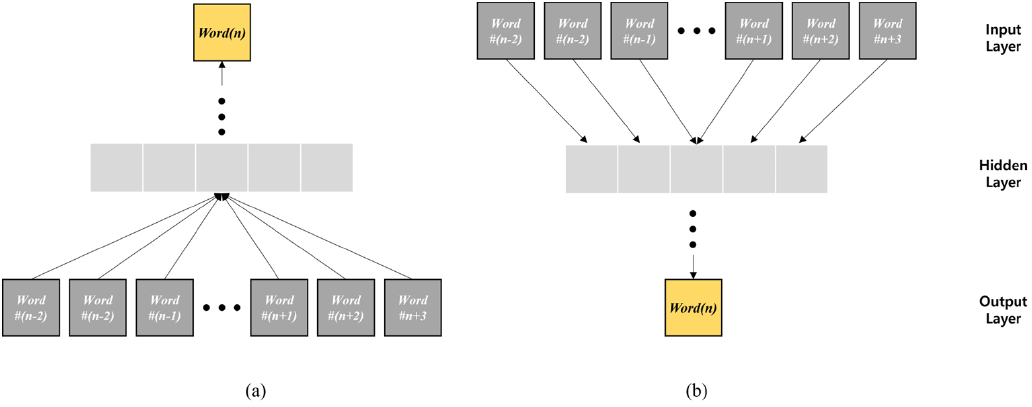
Figure 1. W2V architecture: ( a ) CBOW, ( b ) skip-gram [17]. The CBOW model uses a continuous distributed representation of the context. This model is characterized by predicting the current word (center word) in context. In particular, given the context, the missing word is predicted according to the window size. By comparison, the continuous skip-gram model, which is similar to CBOW, strives to maximize the classification of words based on other words in the same sentence. Because a word having low relevance to the current word is located farther than a related word, less weights are assigned to the farther-located words than nearby words by a smaller number of samples for the corresponding word.